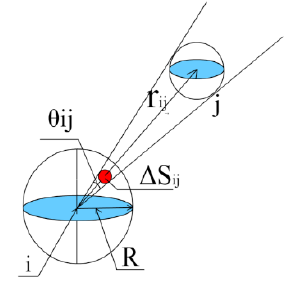
Fig. 1. Micro surface area Δ𝑆 𝑖𝑗 between particle i and particle j